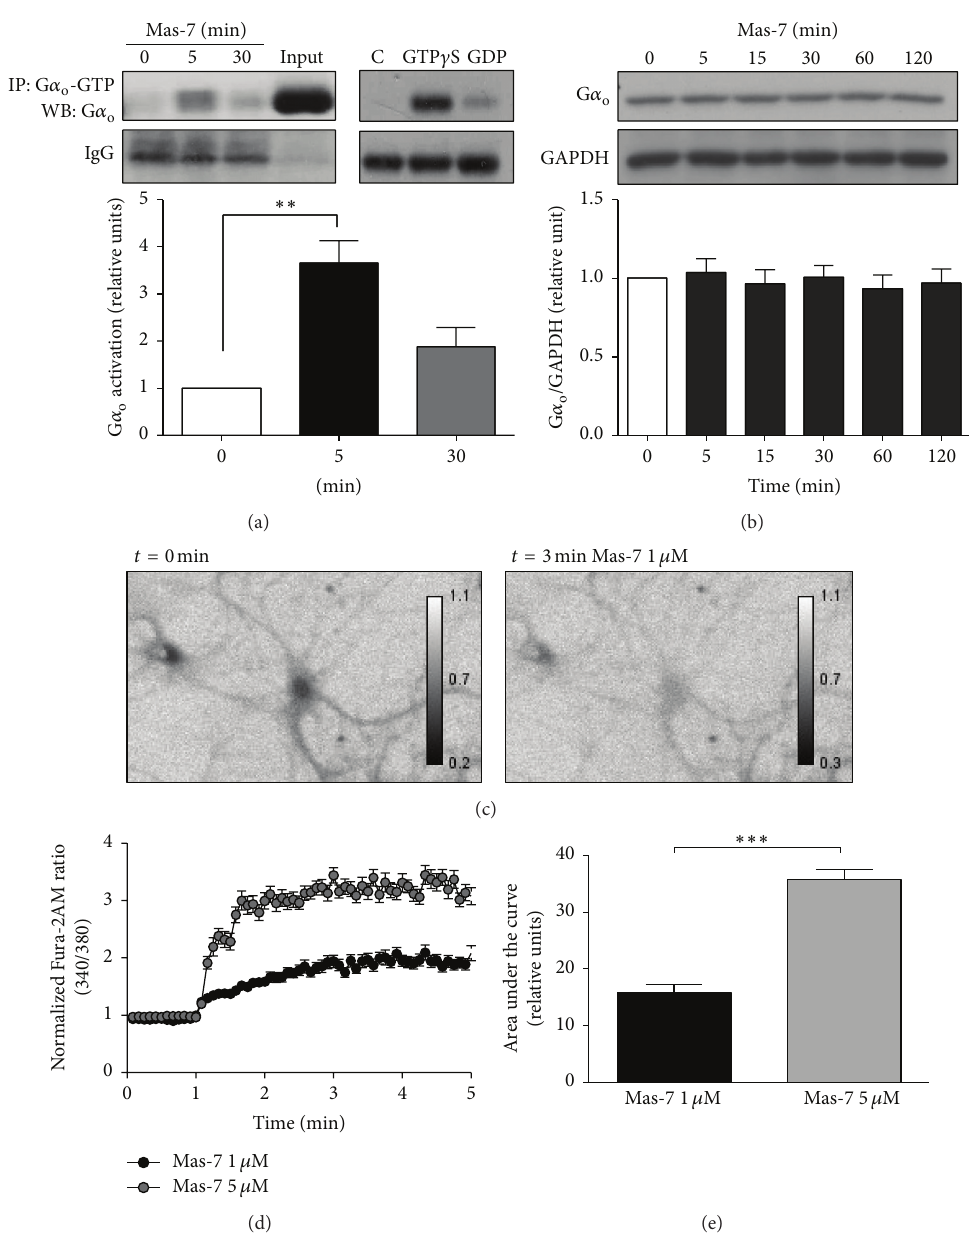
Figure 1: Mas-7 activates the G 𝛼 o subunit and increases the intracellular Ca 2+ concentration in hippocampal neurons. (a) Left panel , 14 DIV hippocampal neurons were stimulated with 1 𝜇 M Mas-7 for 0, 5, or 30min. The neurons were lysed and incubated with anti-G 𝛼 o -GTP for 2h and then analyzed by immunoblotting using an anti-G 𝛼 o antibody ( 𝑛 = 4 ). The input lane corresponds to a lysate sample before the immunoprecipitation. ∗∗ 𝑝 < 0.01 . Right panel, lysates from untreated (control) hippocampal neurons were incubated with GTP 𝛾 S as a positive control or with GDP as a negative control for 90 min at RT. Then, the G 𝛼 o -GTP was immunoprecipitated and analyzed by western blotting to determine the total level of G 𝛼 o . The IgG band shows that an equal amount of antibody was used for the immunoprecipitation. (b) Representative western blot and quantification of the total level of G 𝛼 o in 14 DIV neurons incubated for different periods of time with 1 𝜇 M Mas-7. GAPDH was used as a loading control ( 𝑛 = 4 ). (c) Ratio images (340/380) of the Fura-2AM probe from hippocampal neurons under basal conditions ( 𝑡 = 0 ) or after 3 min of 1 𝜇 M Mas-7 treatment. (d) Quantification of measurements of the intracellular Ca 2+ increase in hippocampal neurons bathed in a Ca 2+ -free solution with different concentrations of Mas-7 ( 𝑛 = 3 , 70–79 neurons, each condition). (e) Area under the curve of the Ca 2+ increase after Mas-7 treatment. ∗∗∗ 𝑝 < 0.001